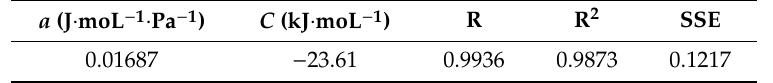
Figure 5. Linear regression curve for the average adsorption energies of CO 2 on MIL-101 (Cr) under different pressures. Table 6. Parameters of and errors in the linear regression for average adsorption energy.